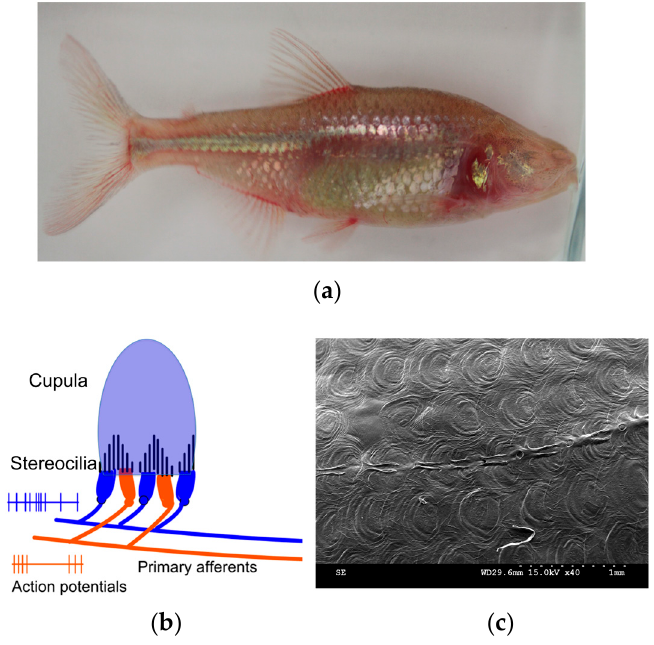
Figure 1. Bioinspiration—biological neuromast flow sensors in blind cavefish: ( a ) A photograph of a blind cave tetra which shows the regressed eyes and pigmentation due to dwelling in dark deep caves; ( b ) A schematic showing the morphology of the biological neuromast sensor, which includes the cupula and the cilia; ( c ) A scanning electron microscope (SEM) image of the lateral-line of the blind cave fish that runs across the length of the fish on the sides.